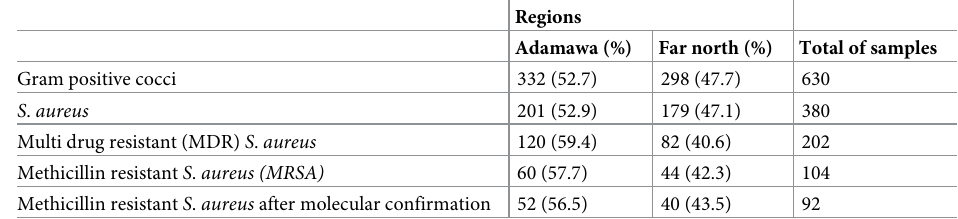
Table 1. Prevalence of Staphylococcus aureus among clinical samples collected between April 2019 to December